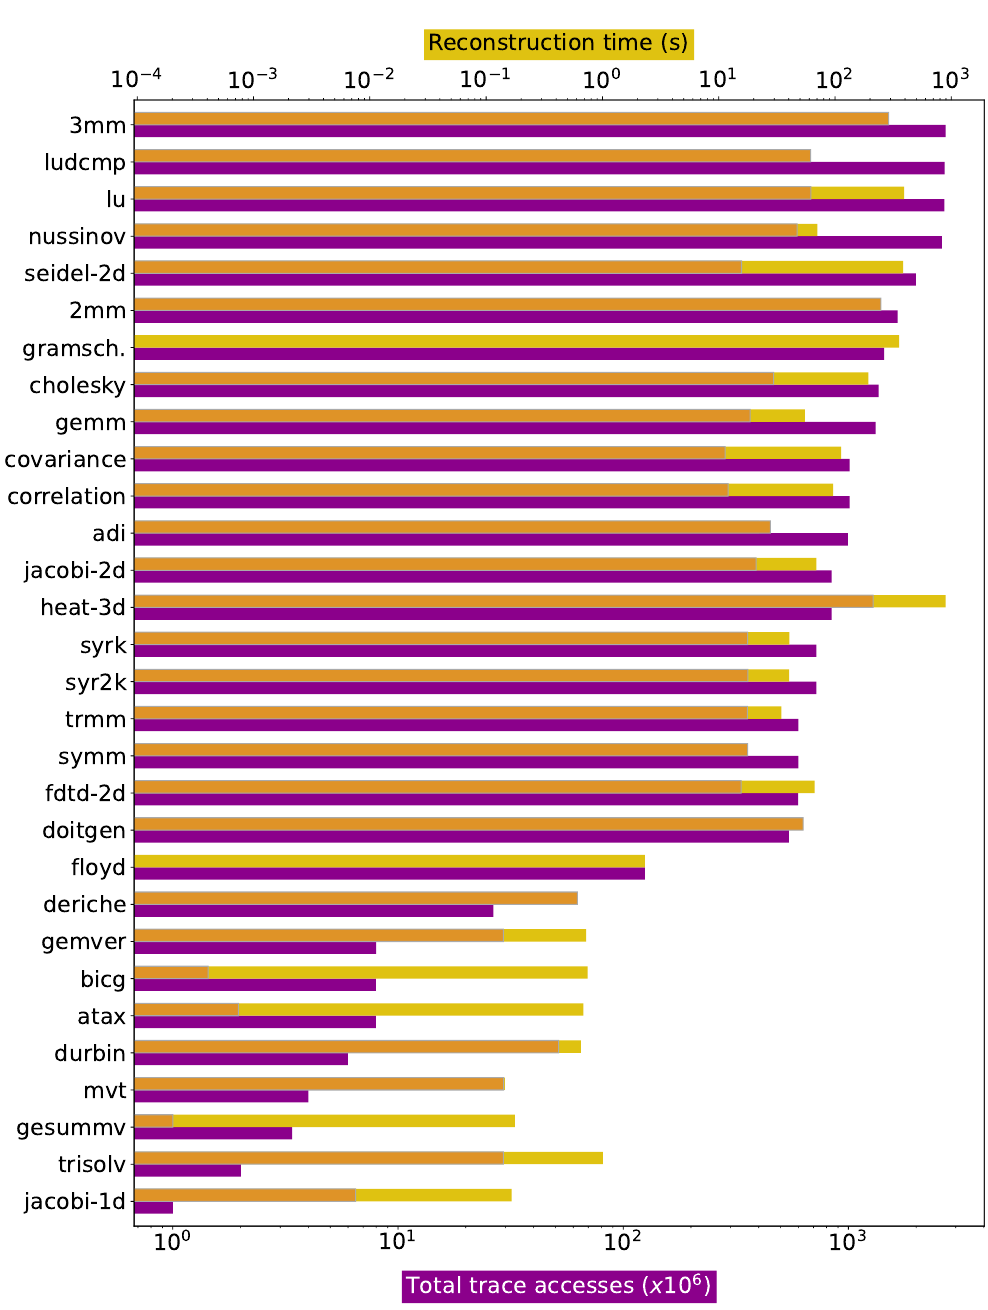
Figure 11. Reconstruction times (upper axis) and trace sizes (lower axis) for the tiled PolyBench/C benchmarks, ordered by trace size. Axes are logarithmic. The left bar in the time axis represents the reconstruction time for the original, untiled code and is included for